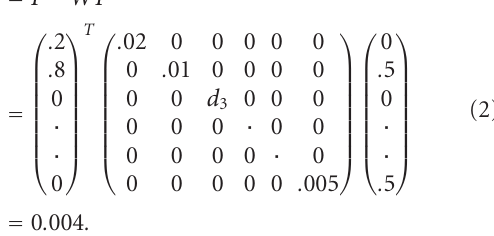
Take Figure 4 (middle) as an